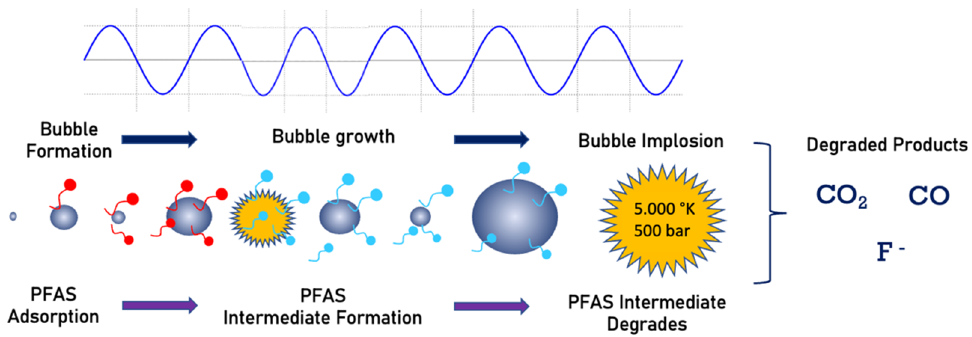
Figure 5. Sonolysis process of PFAS mineralization.